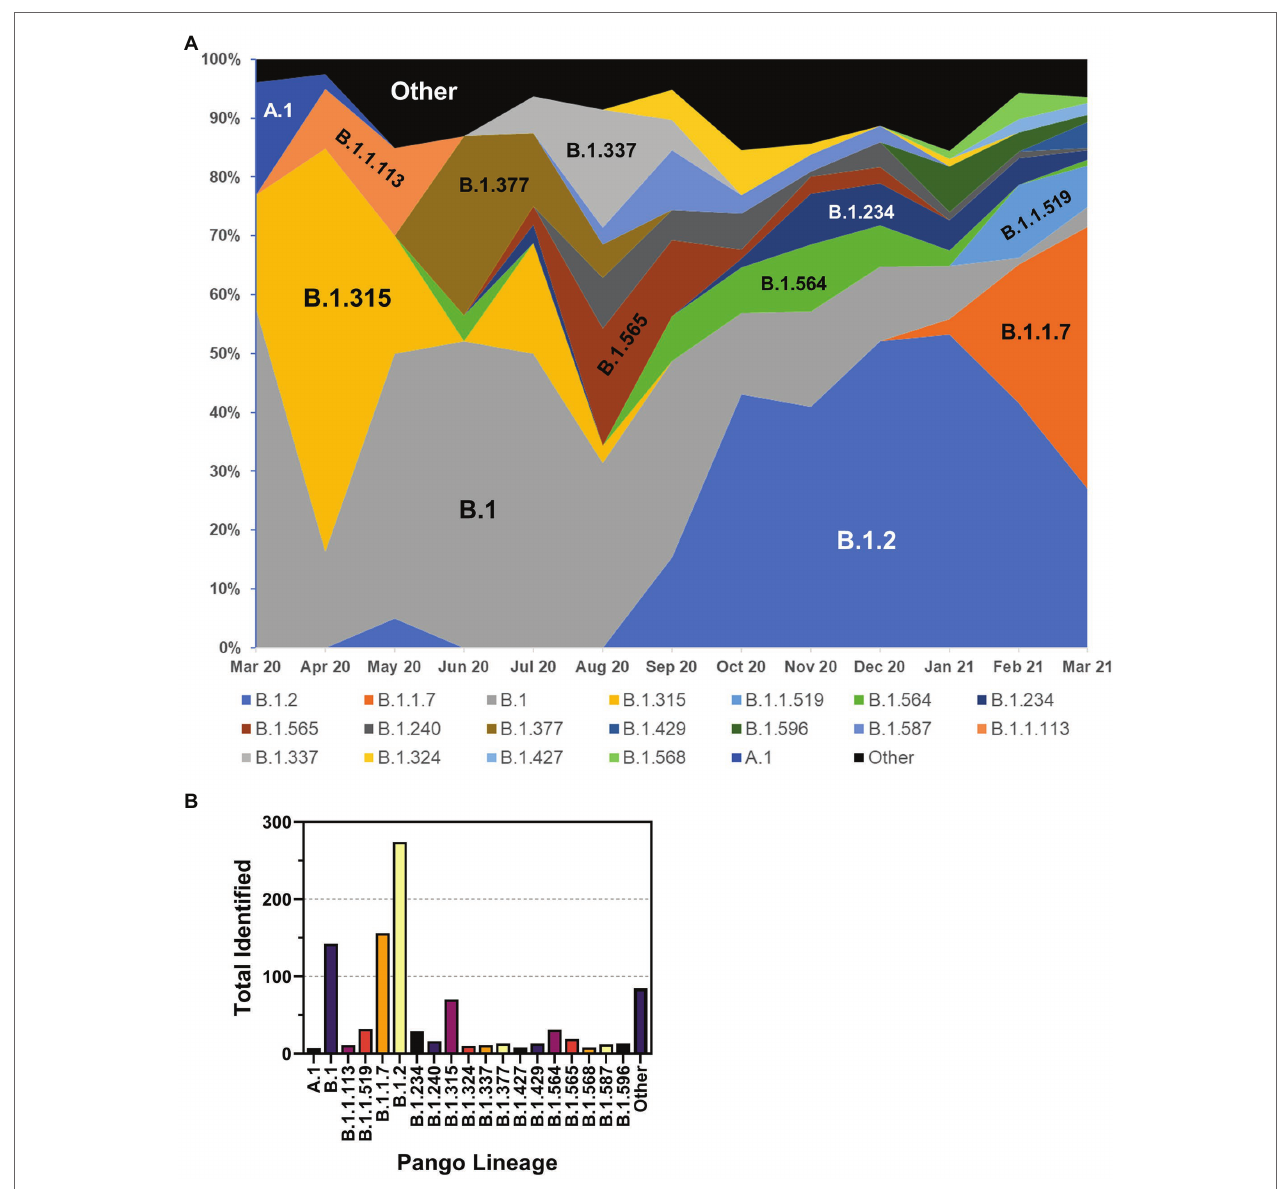
FIGURE 6 | Distribution of PANGO lineages of NE samples. (A) Monthly frequency distribution of the PANGO lineages of the most prevalent lineages observed among sequenced samples. (B) Summary graph of the total number of samples observed from March 2020–March 2021 of indicated PANGO